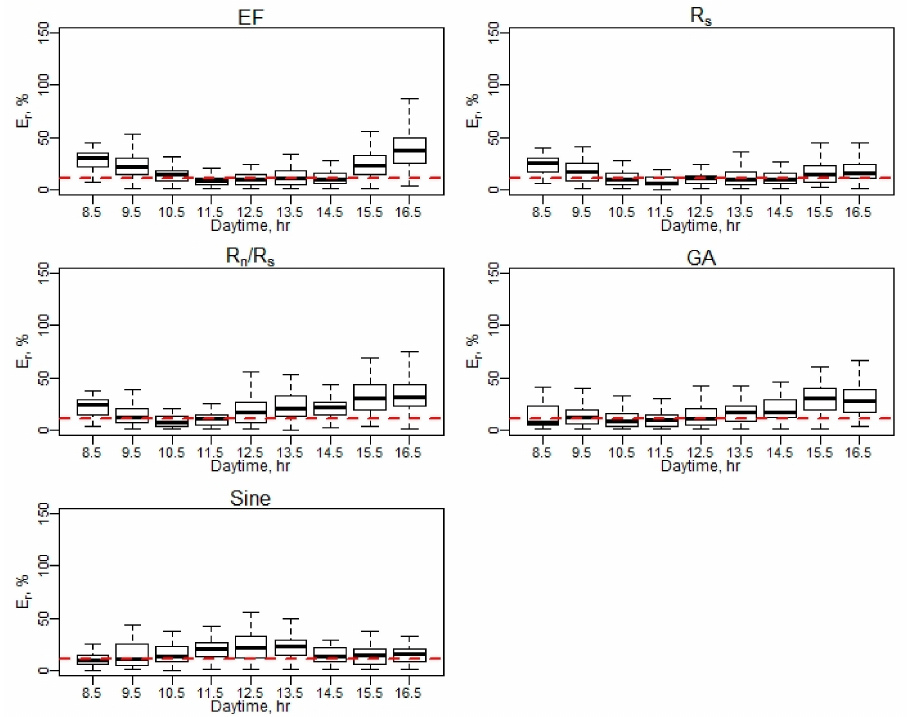
Figure A22. E r of daily EC ET